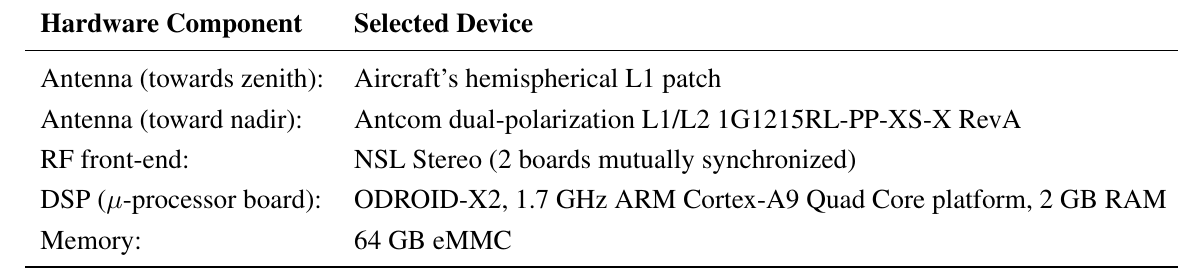
Table 1. Summary of the selected principal hardware components. eMMC, embedded multimedia